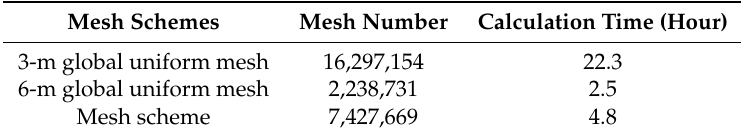
Table 7. Mesh number and calculation